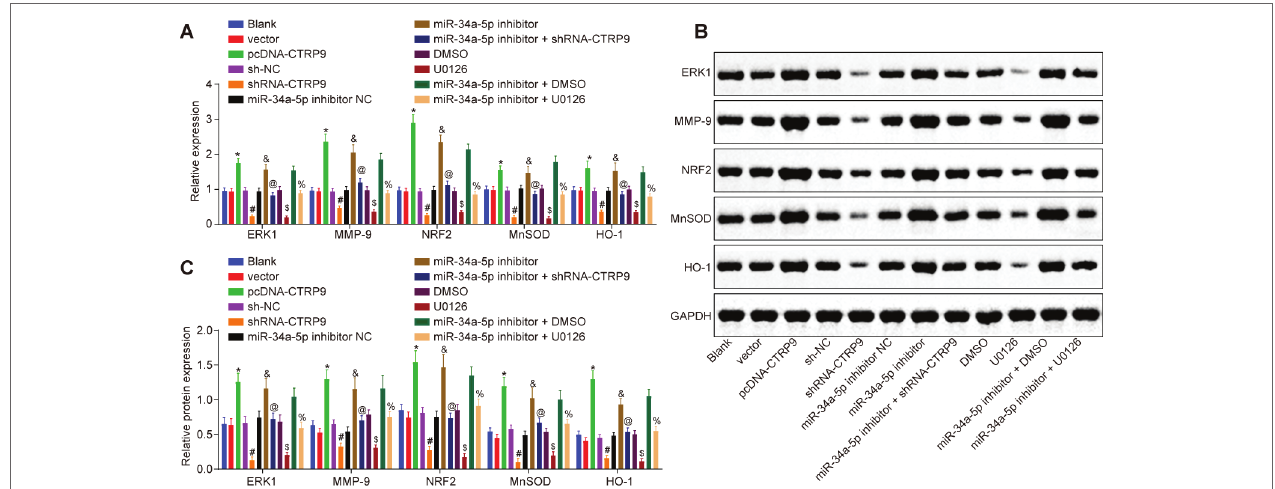
FIGURE 2 | Down-regulation of miR-34a-5p promotes CTRP9 expression. (A) The expression of ERK1, MMP-9, NRF2, MnSOD, and HO-1 in ADSCs detected by RT-qPCR. (B,C) Western blot analysis of ERK1, MMP-9, NRF2, MnSOD, and HO-1 proteins in ADSCs. * p < 0.05 vs. the vector group; # p < 0.05 vs. the sh-NC group; & p < 0.05 vs. the miR-34a-5p inhibitor NC group; @ p < 0.05 vs. the miR-34a-5p inhibitor group; $ p < 0.05 vs. the DMSO group; % p < 0.05 vs. the miR-34a-5p inhibitor + DMSO group; Data (mean ± s.d.) among multiple groups were analyzed by one-way ANOVA, followed by Tukey’s post hoc test. Log-rank was used for univariate analysis. The experiment was repeated three times. CTRP9, C1q/tumor necrosis factor-related protein-9; miR-34a-5p, microRNA-34a-5p; ERK1, extracellular signal-regulated kinase 1; MMP-9, matrix metalloproteinase-9; NRF2, nuclear factor (erythroid-derived 2)-like 2; MnSOD, manganese superoxide dismutase; HO-1, heme oxygenase-1; RT-qPCR, reverse transcription quantitative polymerase chain reaction; ADSCs, adipose-derived stem cells; sh, short hairpin; NC, negative control; DMSO, dimethyl sulfoxide; s.d., standard deviation; ANOVA, analysis of variance.